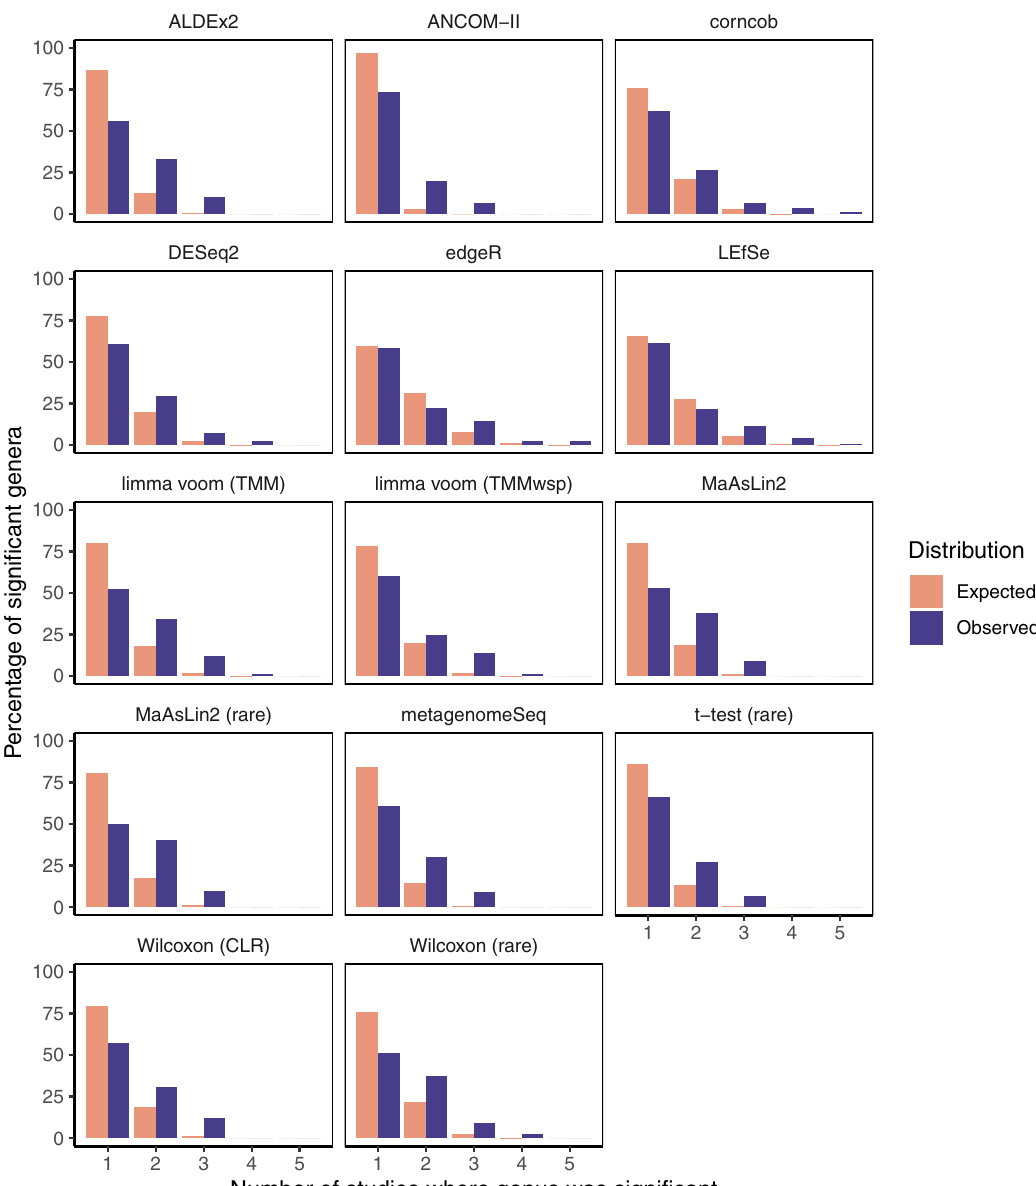
Fig. 5 Observed consistency of signi fi cant genera across diarrhea datasets is higher than the random expectation overall. These barplots illustrate the distributions of the number of studies for which each genus was identi fi ed as signi fi cant (excluding genera never found to be signi fi cant). The random expectation distribution is based on replicates of randomly selecting genera as signi fi cant and then computing the consistency across studies. Abbreviations: TMM, trimmed mean of M-values; TMMwsp, trimmed mean of M-values with singleton pairing; rare, rare fi ed; CLR, center-log-ratio. Source data are provided as a Source Data fi